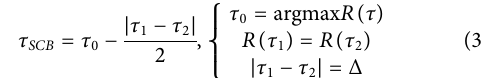
FIGURE 4 Correlation peak comparison between ideal and non-ideal channel